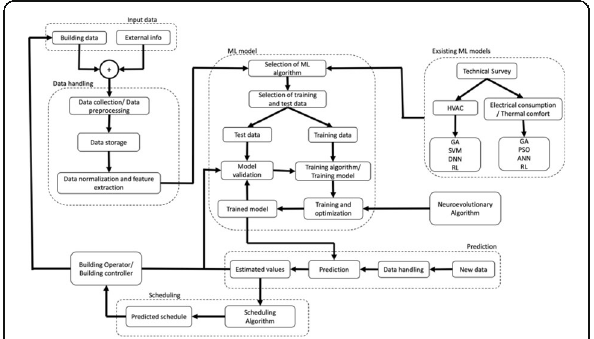
Fig. 1 (Abstract P6). The proposed